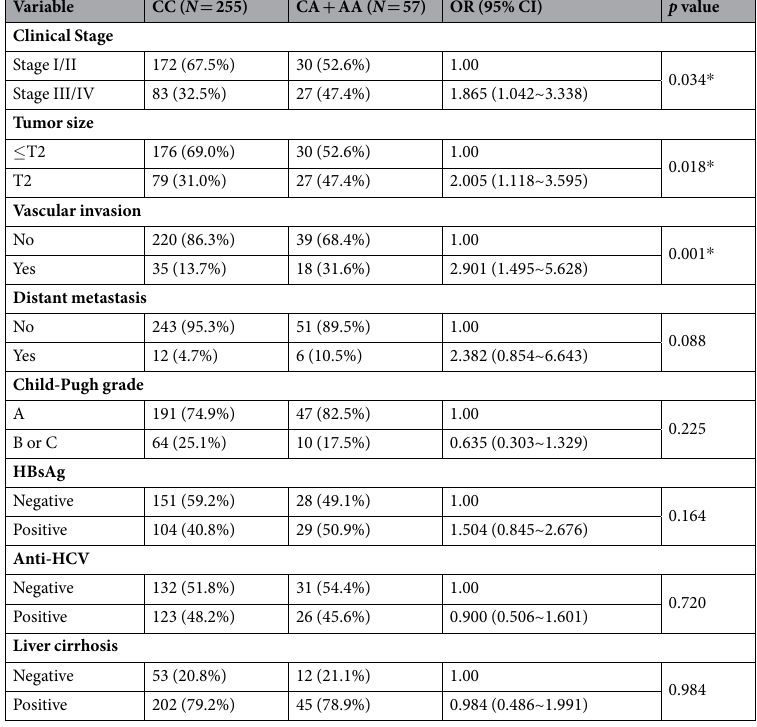
Table 1. Clinical status and CA9 rs1048638 genotypic frequencies in 312 patients with hepatocellular carcinoma. See also Tables S1–S5. T2: multiple tumor of > 5 cm or tumor involving a major branch of the portal or hepatic veins. HBsAg, surface antigen of hepatitis virus; HCV, hepatitis C virus; OR, odds ratio; CI, confidence